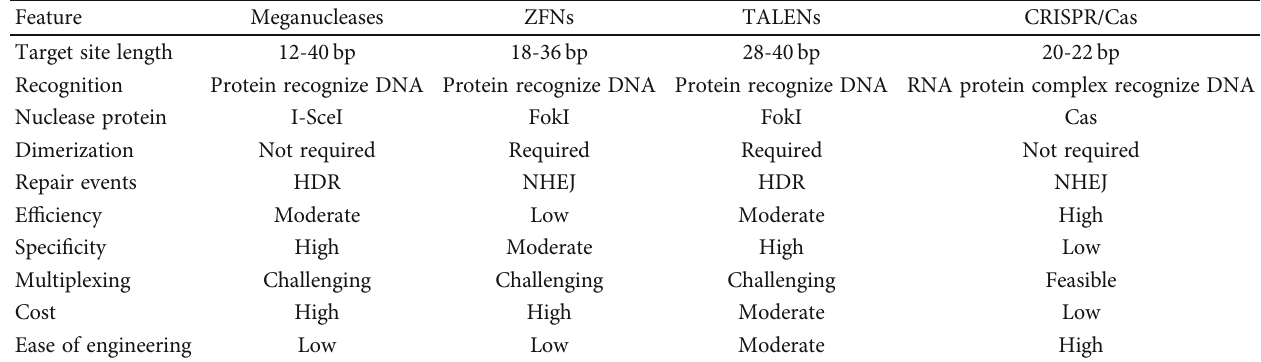
Table 1: Comparison of di ff erent types of genome editing tools [142 –